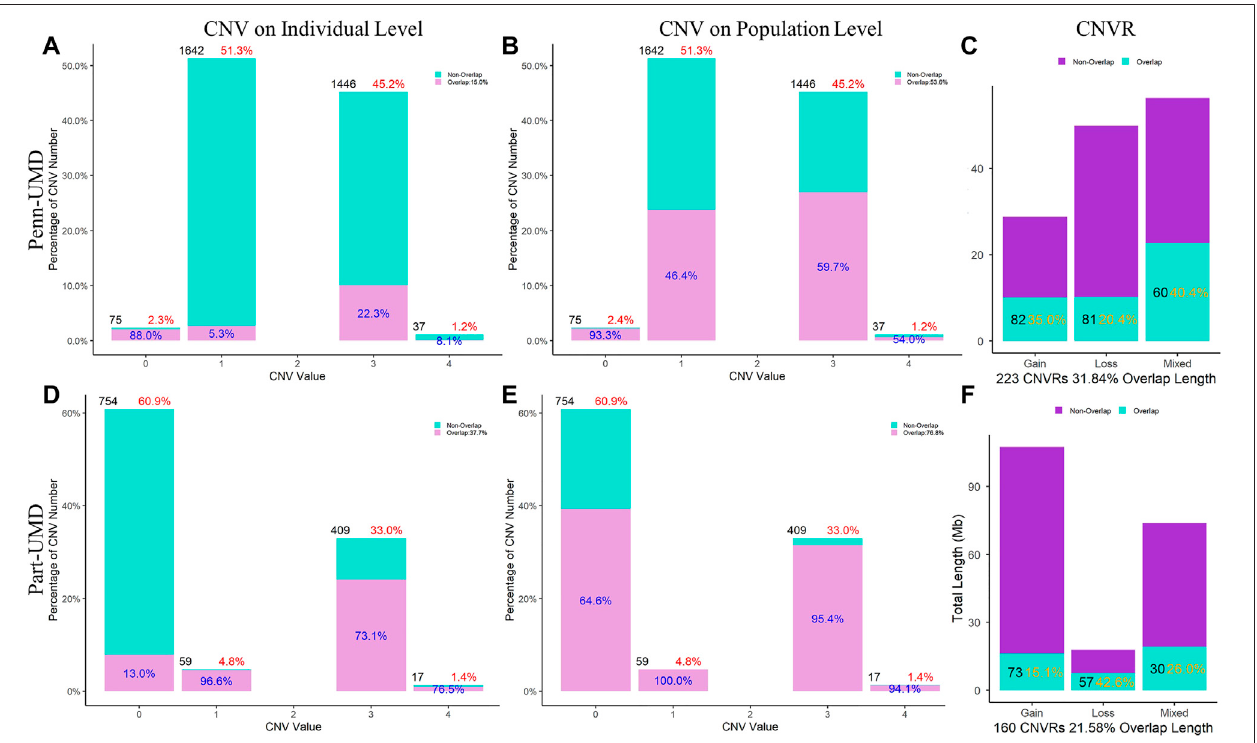
FIGURE6| ComparisonofCNVsandCNVRsbetweenthePenn-ARSandPart-ARSresults. (A) and (D) aretheCNVscomparisonresultsonindividuallevels. (B) and (E) are the CNVs comparison results on population level. The percentage in red indicates the proportion of the number of CNVs with different states to the total number of CNVs.ThepercentageinblueindicatestheproportionofthenumberofoverlappingCNVstoeachCNVstategroup. (C) and (F) aretheCNVRscomparison.Thepercentage in orange represents the proportions of overlapping length of CNVRs to the total length of each type group. Comparison of CNVRs to known CNV datasets.